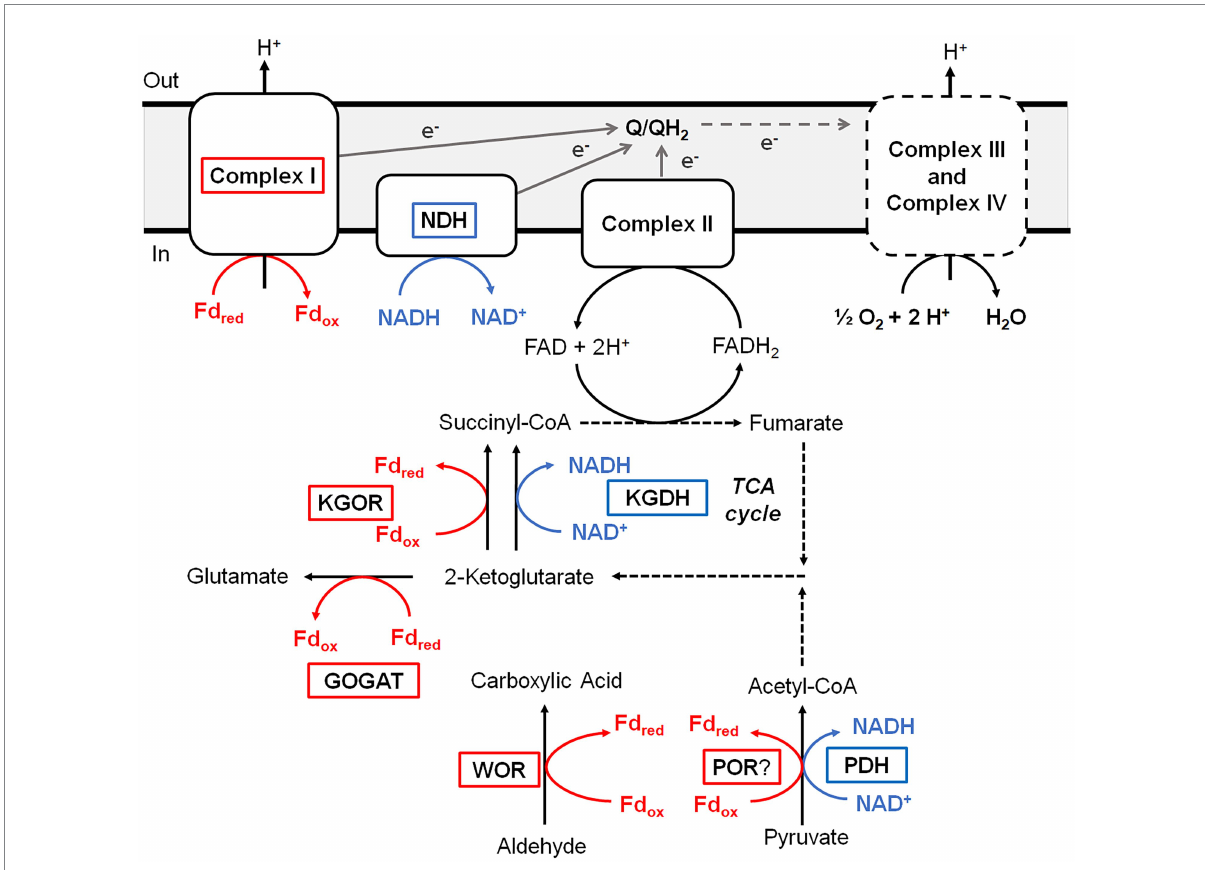
FIGURE 6 Predicted roles of WOR and other Fd-dependent enzymes during aerobic respiration of B. massiliensis . Aldehydes and amino acids are metabolized to CO 2 utilizing the TCA cycle generating reduced Fd (red) and NADH (blue). Reduced Fd and NADH are then used to generate electrons that flow through the quinone pool (Q/QH 2 ) before ultimately reducing O 2 as the final electron acceptor. Fd-dependent enzymes are boxed red, NAD-dependent enzymes are boxed blue and dotted lines indicate multiple steps. See text for